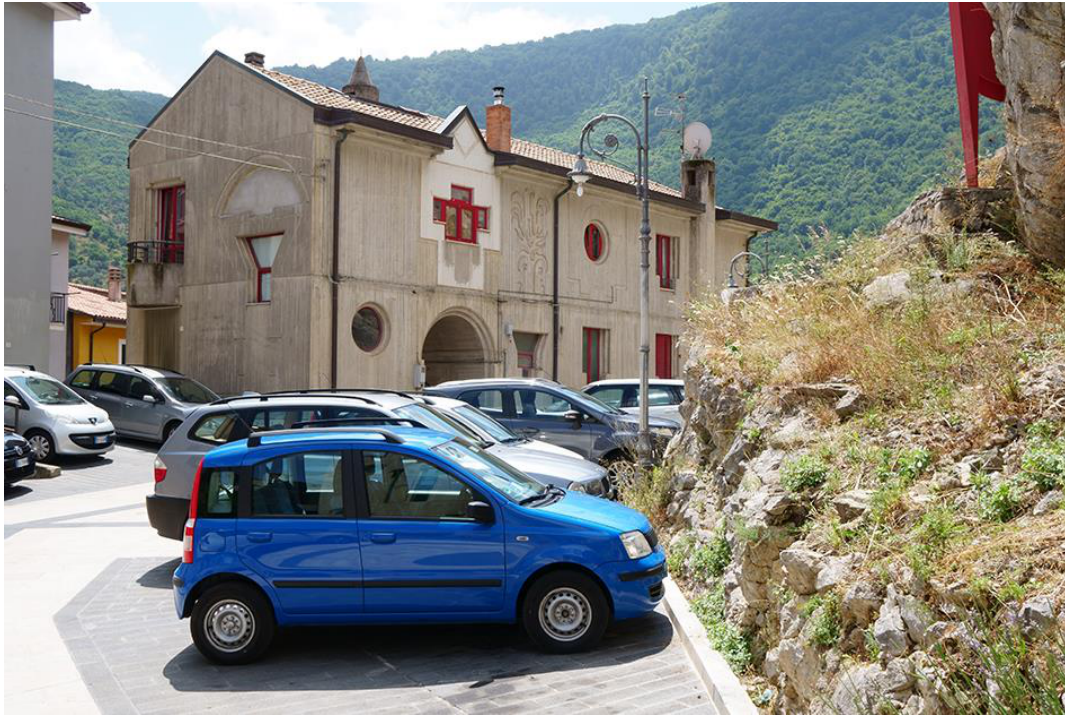
Figure 42. Balvano: the new buildings details of the architecture by R. Boffo and K. Eibl (photos by [35,36]).